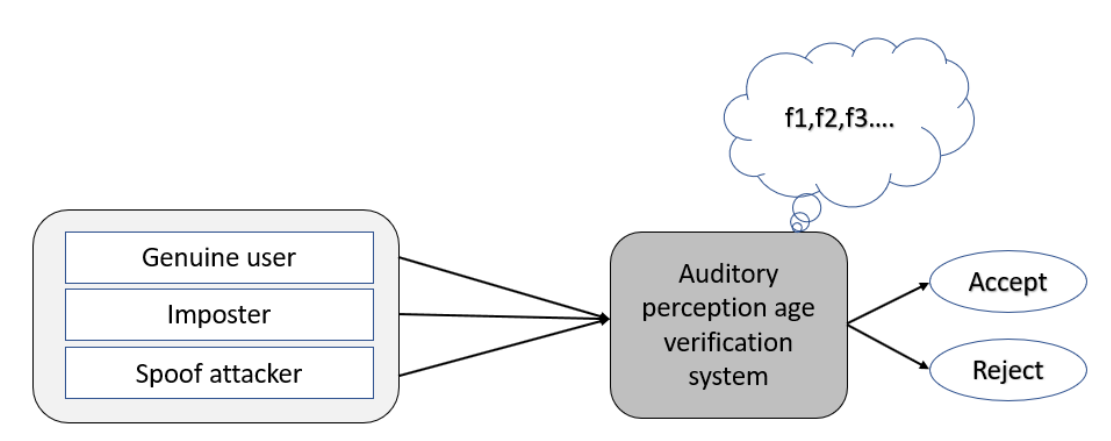
Figure 3. Auditory perception based anti-spoofing